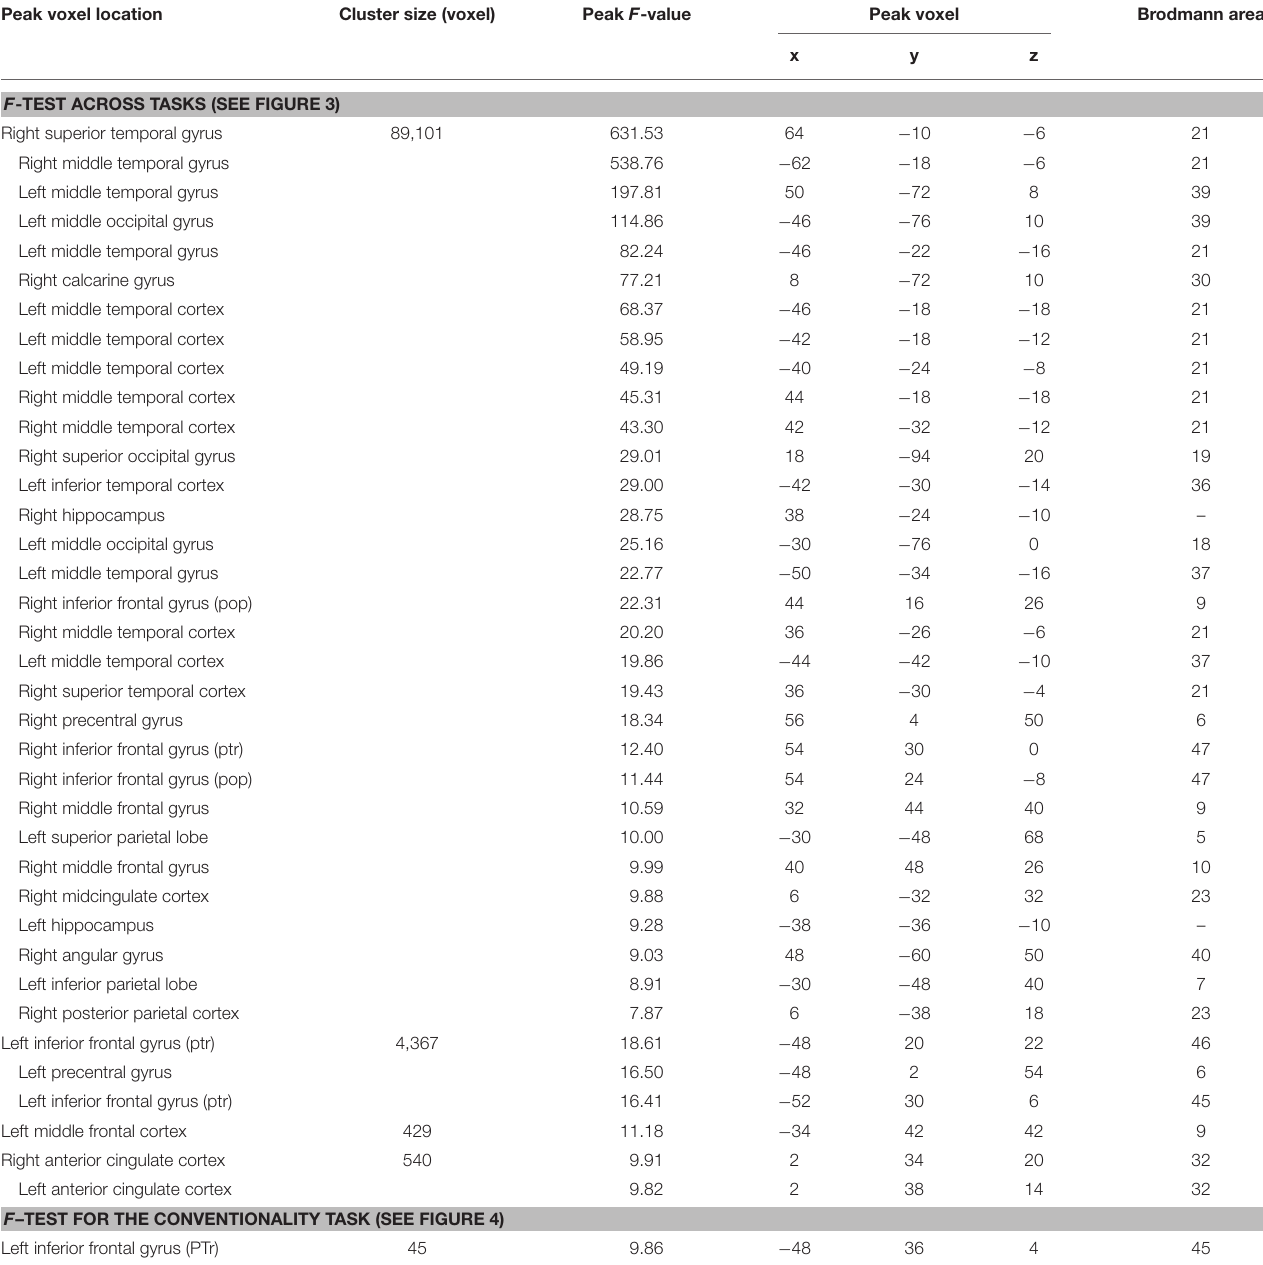
TABLE 2 | Cluster table for ISC maps. Peak voxel